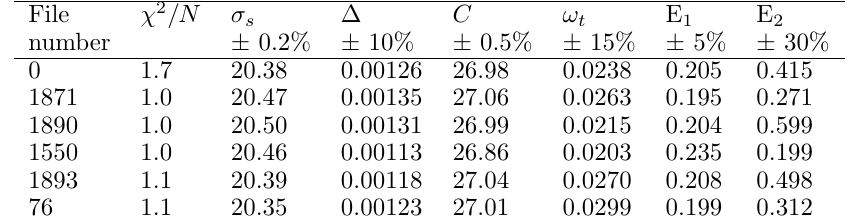
Fig. 3. Calculated over Experimental values for the considered criticality benchmarks. The case “Best” corresponds to a selected H in H 2 O thermal scattering data case. Table 2. Nominal (unperturbed) CAB parameters (file number 0) and sampled parameters leading to the minimum χ 2 (file number